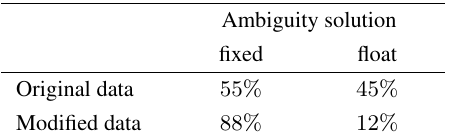
Table 2. Success rate of ambiguity